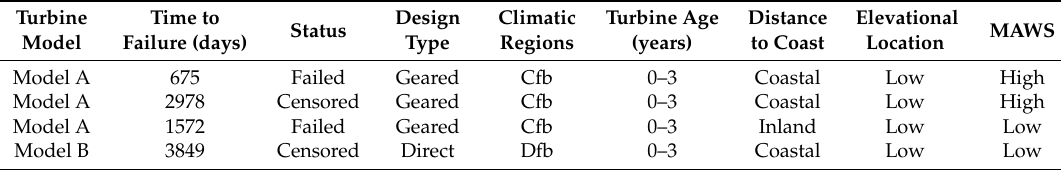
Table 3. Sample data used for survival analysis of the switch